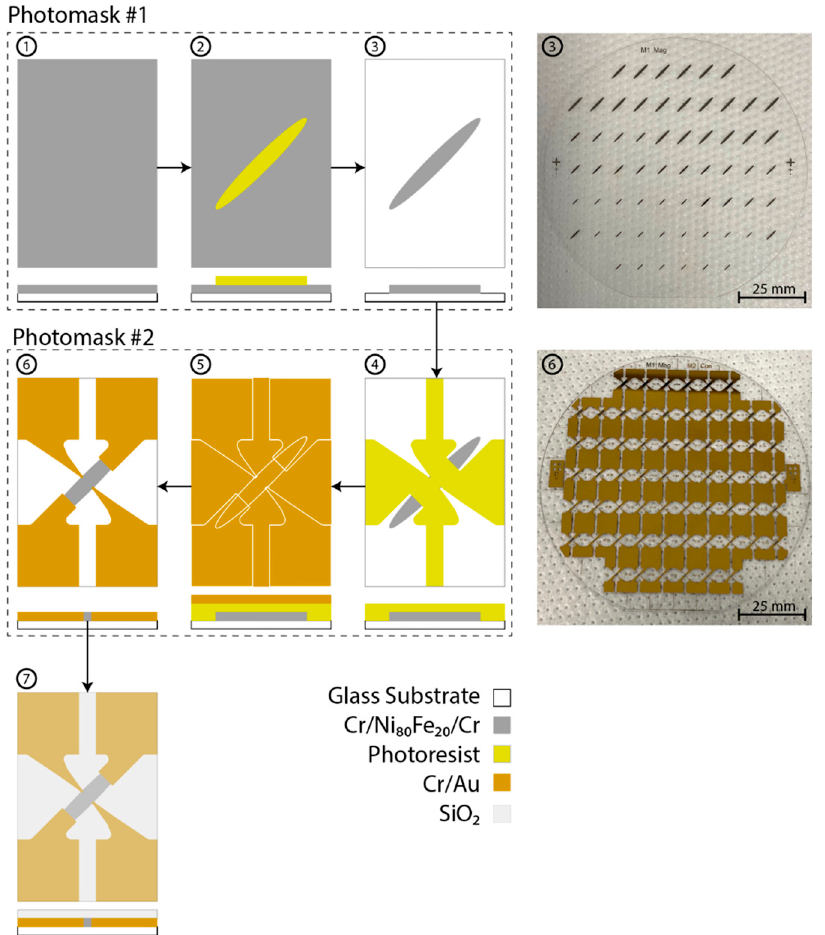
Figure A1. Microfabrication process of the EPHE sensor demonstrating a single sensor’s top and side view. ( 1 ) EBPVD deposited Cr/Ni 80 Fe 20 /Cr. ( 2 ) Elliptical feature patterned with photoresist using photomask #1. ( 3 ) Revealed elliptical thin film after wet-etching, and photo of the actual wafer. ( 4 ) Contact pad patterned with photoresist using photomask #2. ( 5 ) EBPVD deposited Cr/Au. ( 6 ) Revealed contact pad’s thin film after lift-off, and photo of the actual wafer. ( 7 ) EBPVD deposited SiO 2 film.